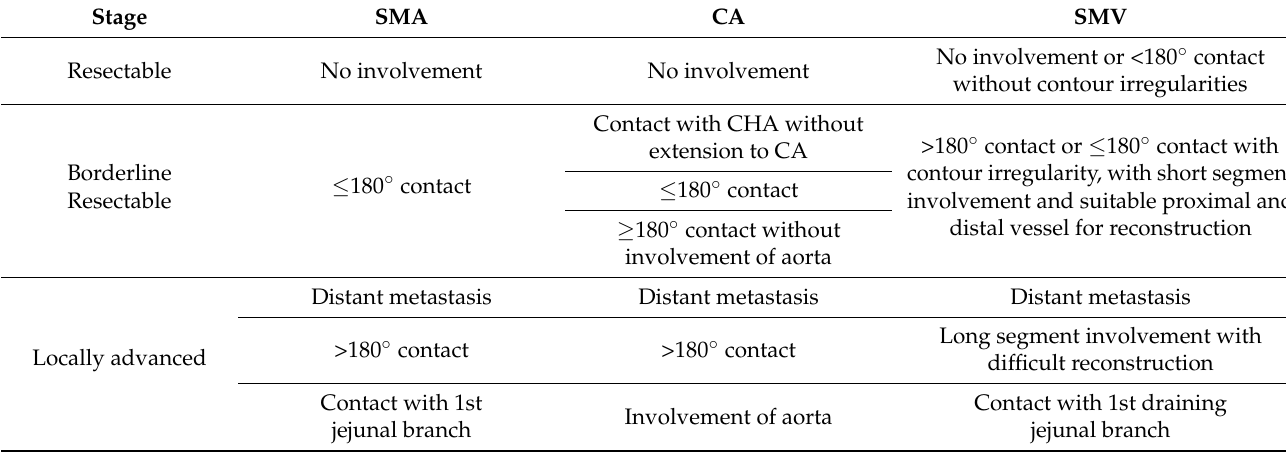
Table 1. Resectability criteria based on NCCN (National Comprehensive Cancer Network) and AHPBA/SSO/SSAT (Americas HepatoPancreato-Biliary Association/Society of Surgical Oncology/Society for Surgery of the Alimentary Tract)